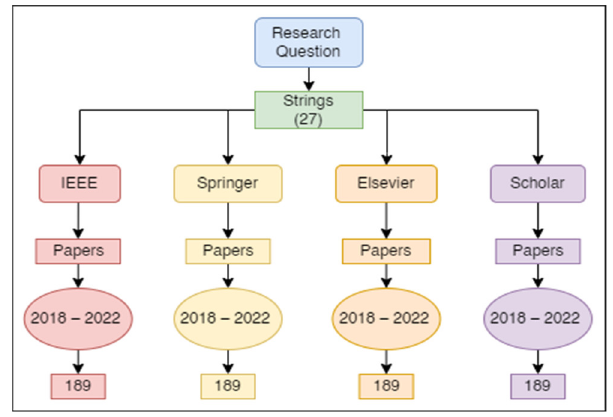
Figure 4. Search strategy using various databases.